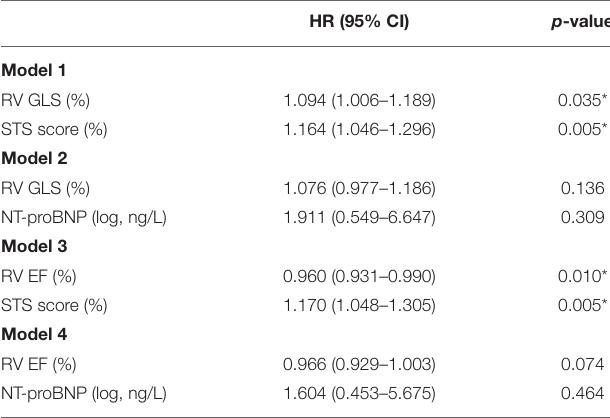
TABLE 3 | RV GLS in multivariate Cox regressions for 1-year all-cause mortality. HR (95% CI) p -value